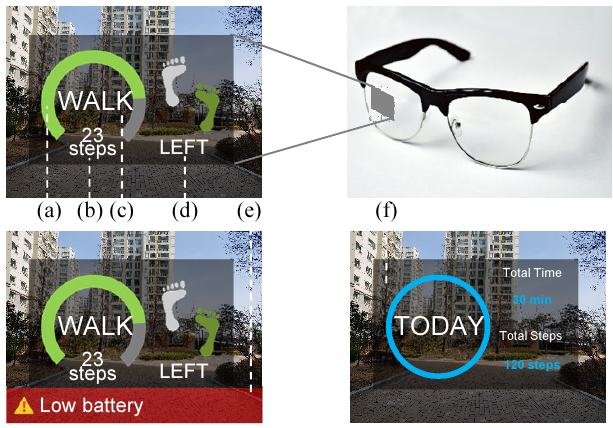
Figure 9. Images shown on the see-through display of smart glasses: ( a ) a progress chart, ( b ) the number of steps, ( c ) the current motion mode, ( d ) the foot placement, ( e ) a warning message and ( f ) the result